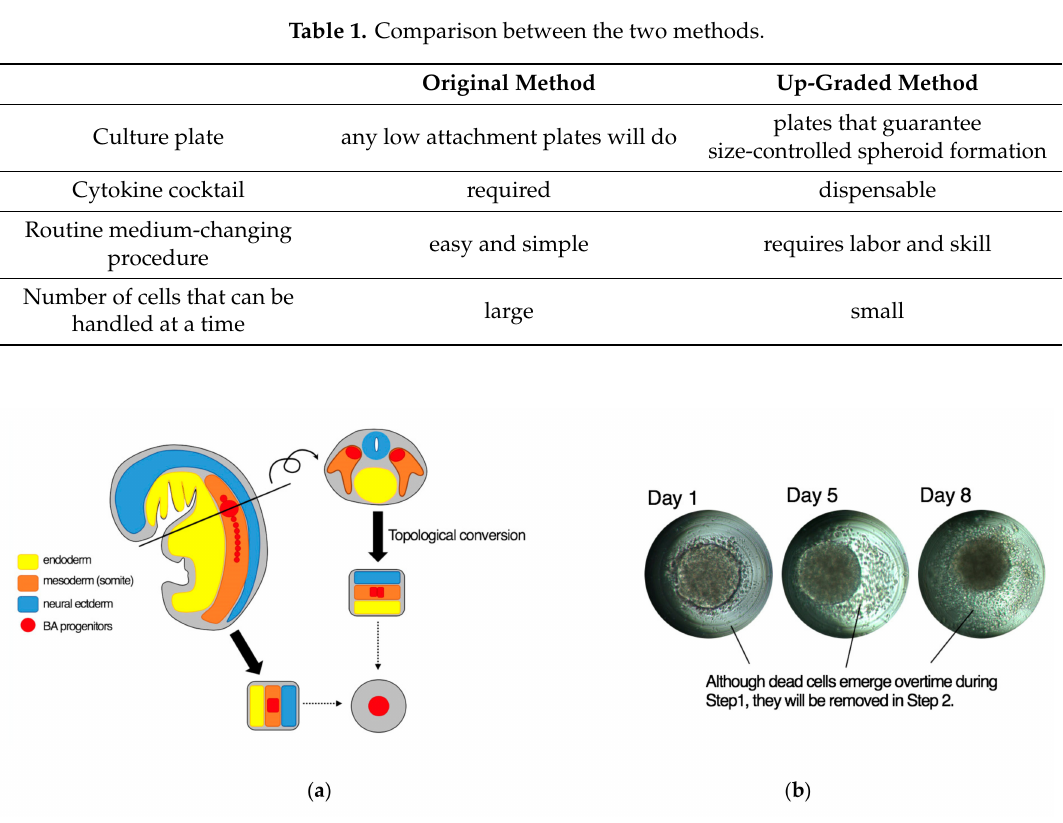
Figure 13. A model for the basis for the cytokine-free di ff erentiation of human pluripotent stem cells into BA. ( a ) BA progenitors could be assumed to reside at the central portion of the developing embryo if embryos were topologically converted into spheres. ( b ) During the culture of human pluripotent stem cell-derived spheroids in a microwell under a cytokine-free condition, increasing numbers of dead cells emerge (~Day 8). However, dead cells are eliminated from the di ff erentiation system after the start of an adherent culture at Day 8. Therefore, the central region of the spheroids consisting of live cells were preferentially transferred to the Step 2 of the di ff erentiation